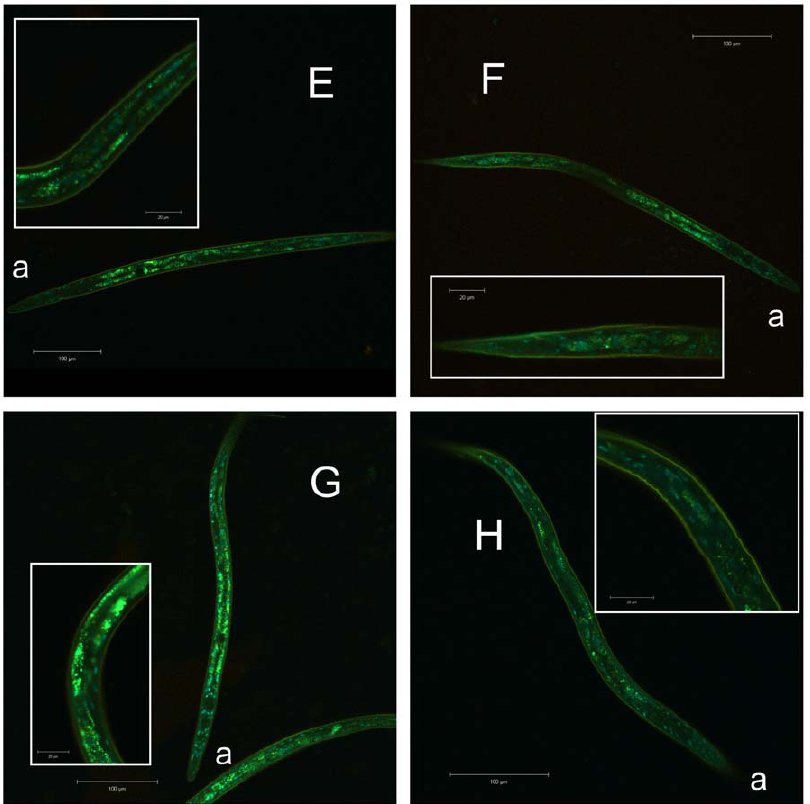
Figure 6. Cellular localization of Ac -DAF-16 double and triple AKT-phospho-mutants in dauer larvae. Pictures are lambda stack images from transgenic daf-2;daf-16 dauers, expressing fusion constructs of double mutants E ) Ac -DAF-16 (S107A/T312A), F ) Ac -DAF-16 (S107A/S381A), G ) Ac -DAF-16 (T312A/ S381A) and H ) Ac -DAF-16 triple mutant. ‘‘a’’ indicates the anterior end.